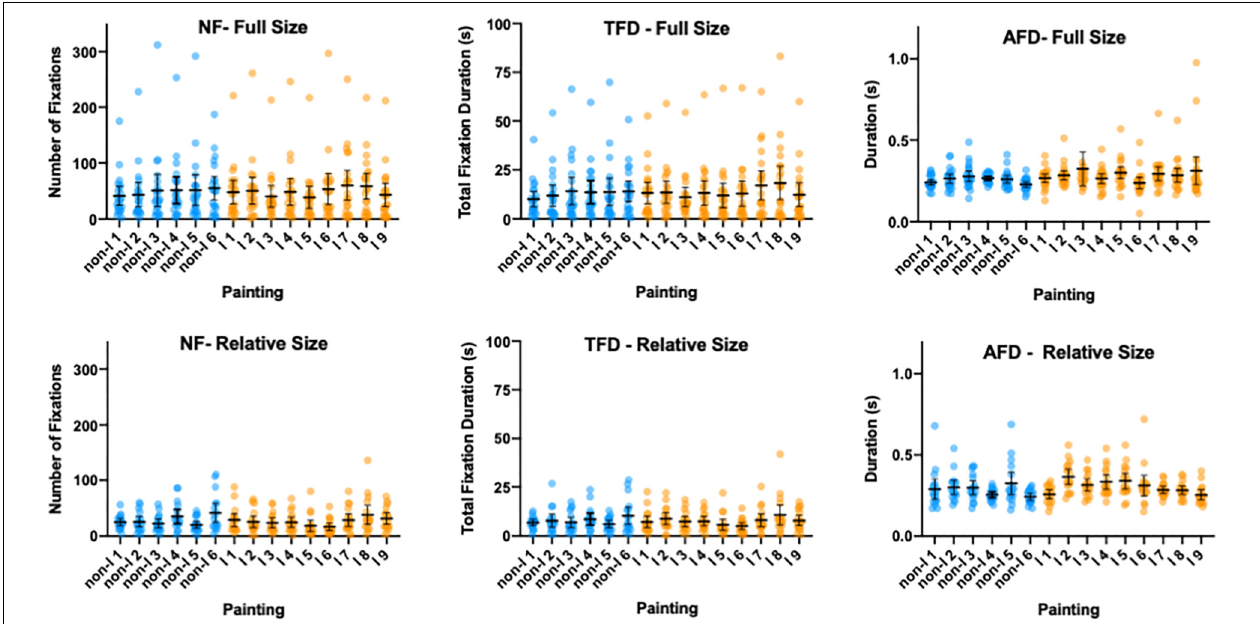
FIGURE 8 | Number of fixations (left panels) ; total fixation duration (middle panels) ; and average fixation duration (left panels) shown for each painting in the full-size screen condition (top row) and the relative size screen condition (bottom row) . Each dot represents data from one participant with the mean with 95% CI for each painting superimposed in black color. The data corresponding to the non-Indigenous and Indigenous paintings shown in blue and orange color, respectively. The paintings in each group are ordered from the smallest to the largest in area for that group. The error bars represent 95% CI.